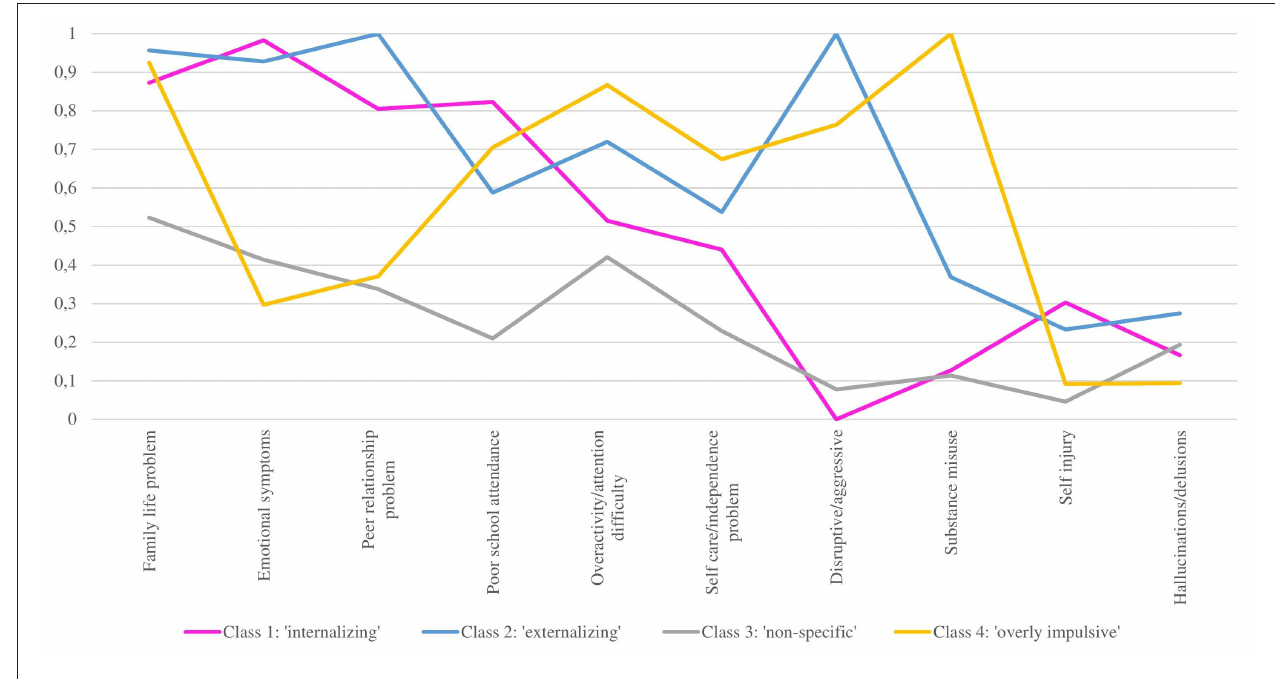
FIGURE 1 | Probability of having a mild/severe problem per class on 10 HoNOSCA items.